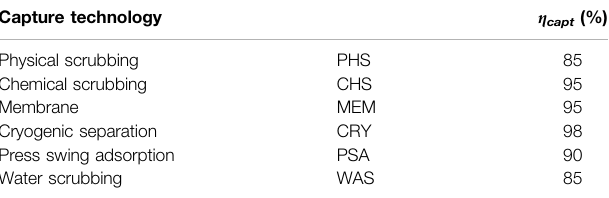
TABLE 2 | Mean carbon dioxide capture ef fi ciency value of upgrading technologies utilized for the biogas plants in Europe (Teir et al., 2014; Huang et al., 2015; Awe et al., 2017; Pellegrini et al., 2020; Riboldi and Bolland, 2015). Capture technology